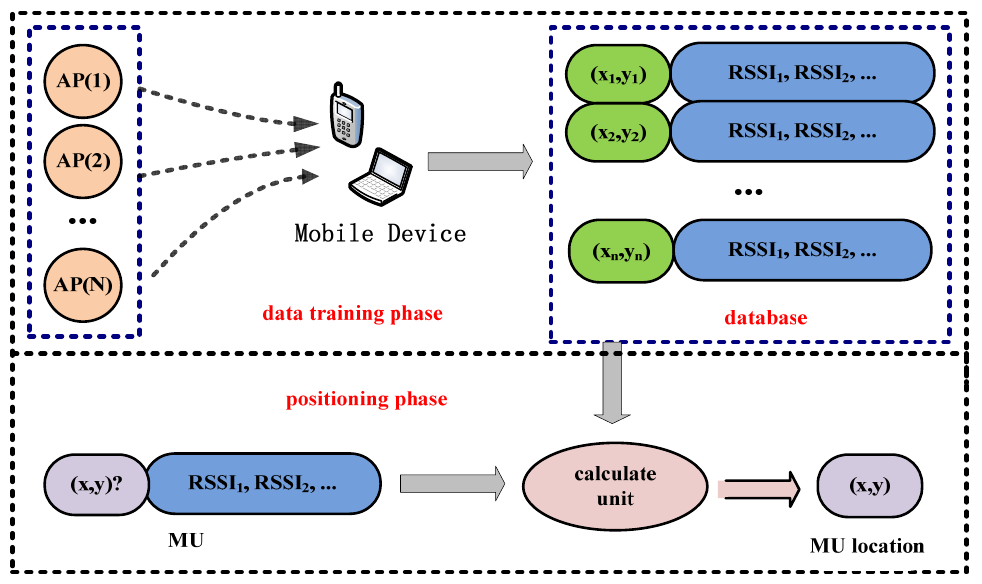
Figure 1. Location fingerprinting